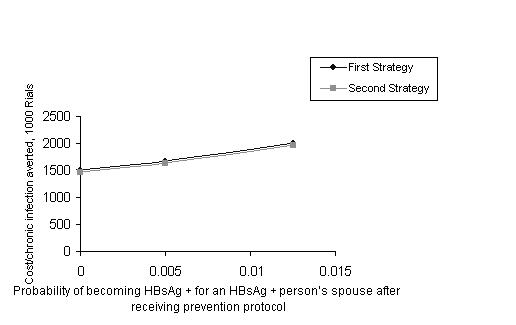
When the probability of becoming HBsAg positive for an HBsAg positive person's spouse after receiving prevention methods (P4) changed from the highest to lowest, the cost per HBV chronic infection averted decreased from 2,010,600 Rials (242 $) to 1,507,950 Rials (182 $) in strategy 1 from 1,959,840 Rials (236 $) to 1,469,880 Rials (177 $) in strategy 2. It shows that higher efficacy of the preventive intervention results in lower costs-effectiveness ratios.